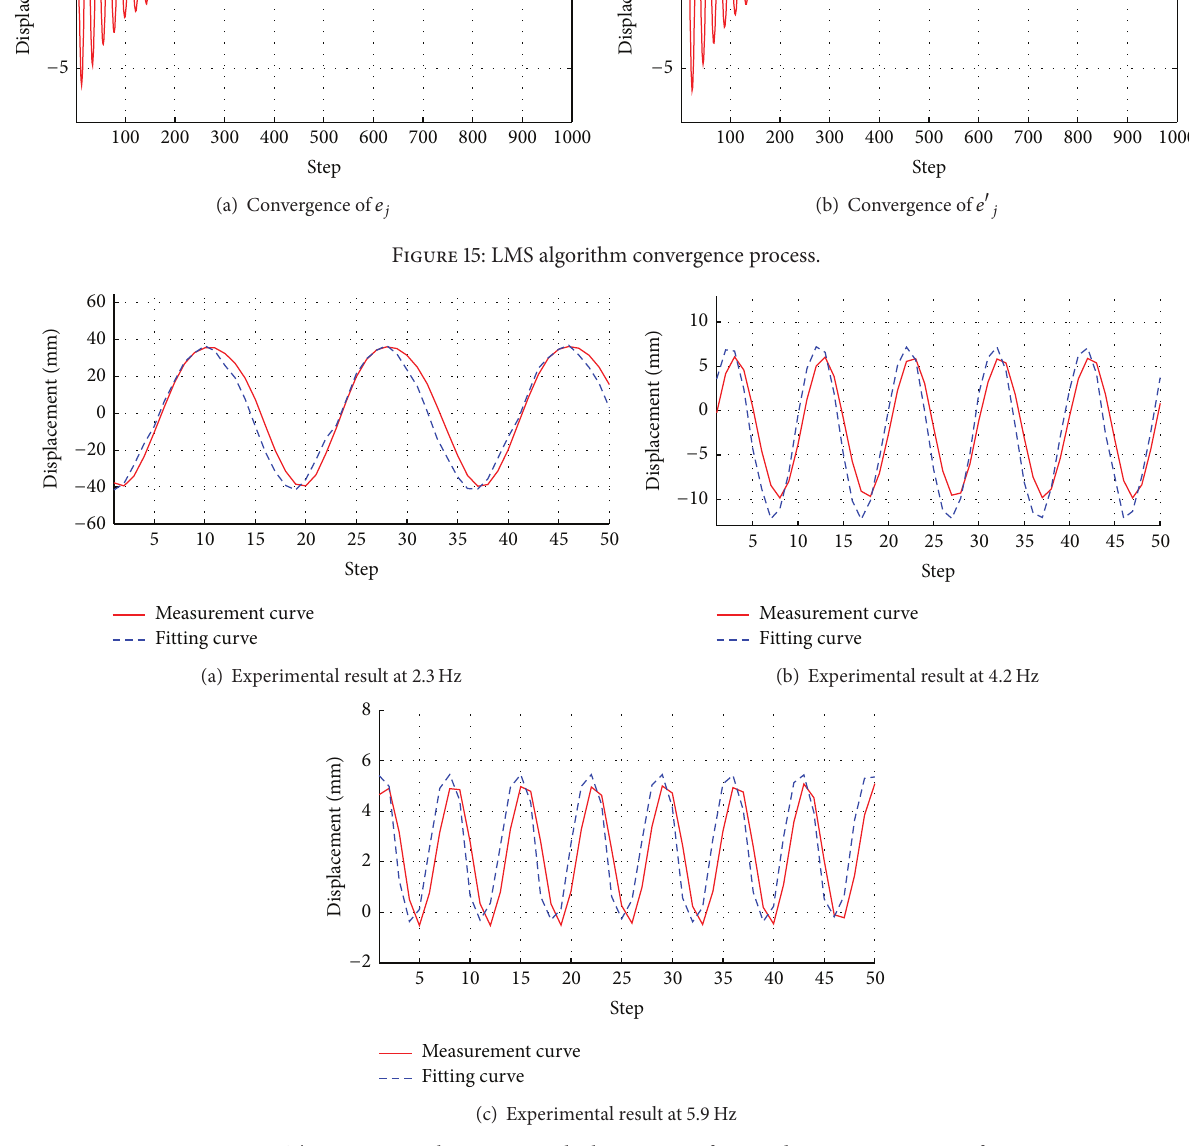
Figure 16: The comparison between actual vibration waveform and reconstruction